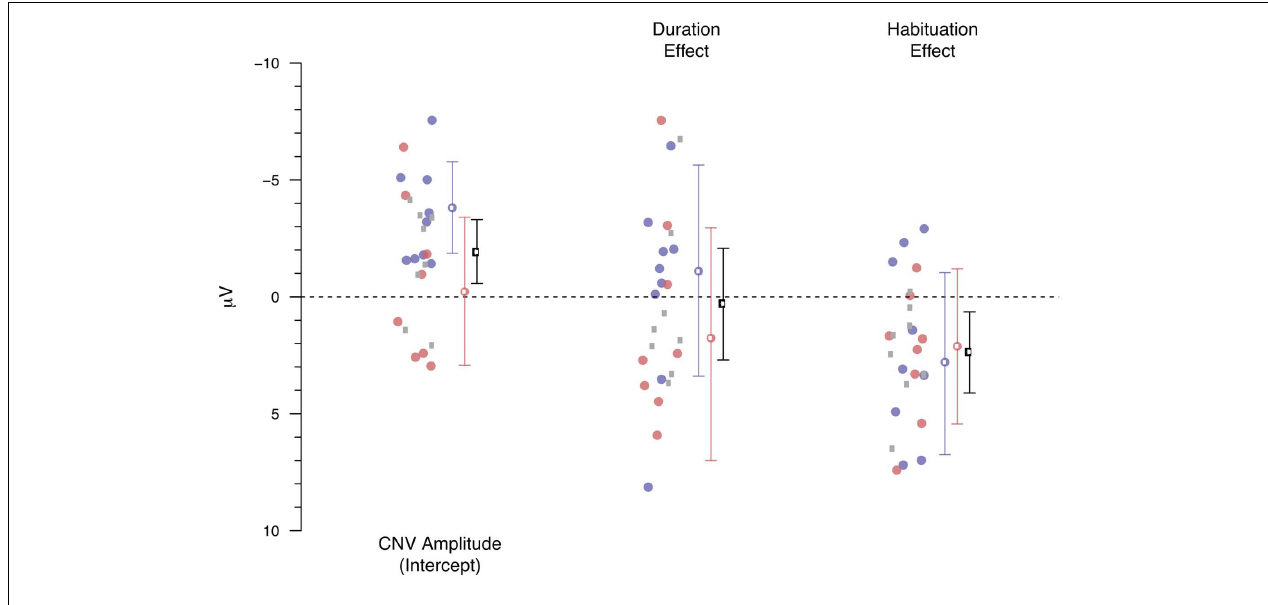
intervals. Blue represents Experiment 1, red Experiment 2, and the gray circles represent the participants who did not meet the “3-in-a-row” criterion.The black means and confidence intervals represent the overall